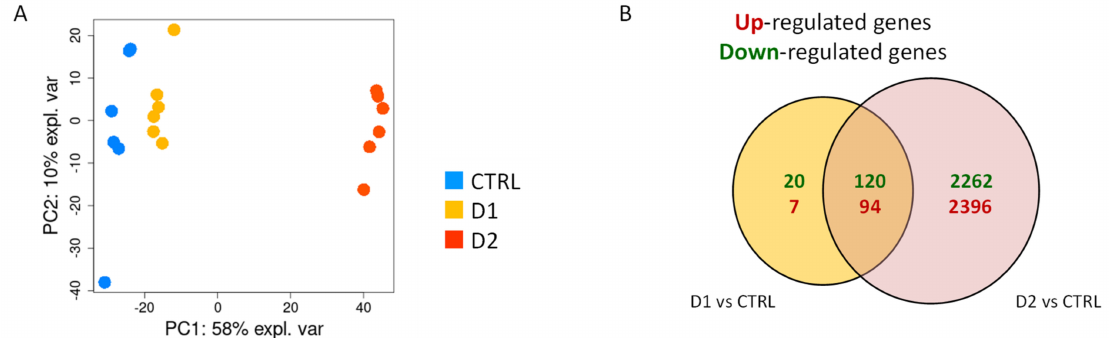
Figure 4. Transcriptomic impact of DMSO on A. flavus cultures. RNA-sequencing data were produced on 6 replicated cultures of A. flavus (control, D1 and D2 DMSO-treated). The data pre-treatment resulted in a count table of detected genes (10,619) for 18 samples. ( A ) Projection of samples on principal components 1 (PC1) and 2 (PC2) from a Principal component analysis (PCA) of log 2 cpm values. A differential analysis identified 4891 regulated genes (FDR < 5%) in response to D1 or D2. ( B ) Venn diagrams of differentially expressed genes (up- or down-regulated) in response to the two doses of